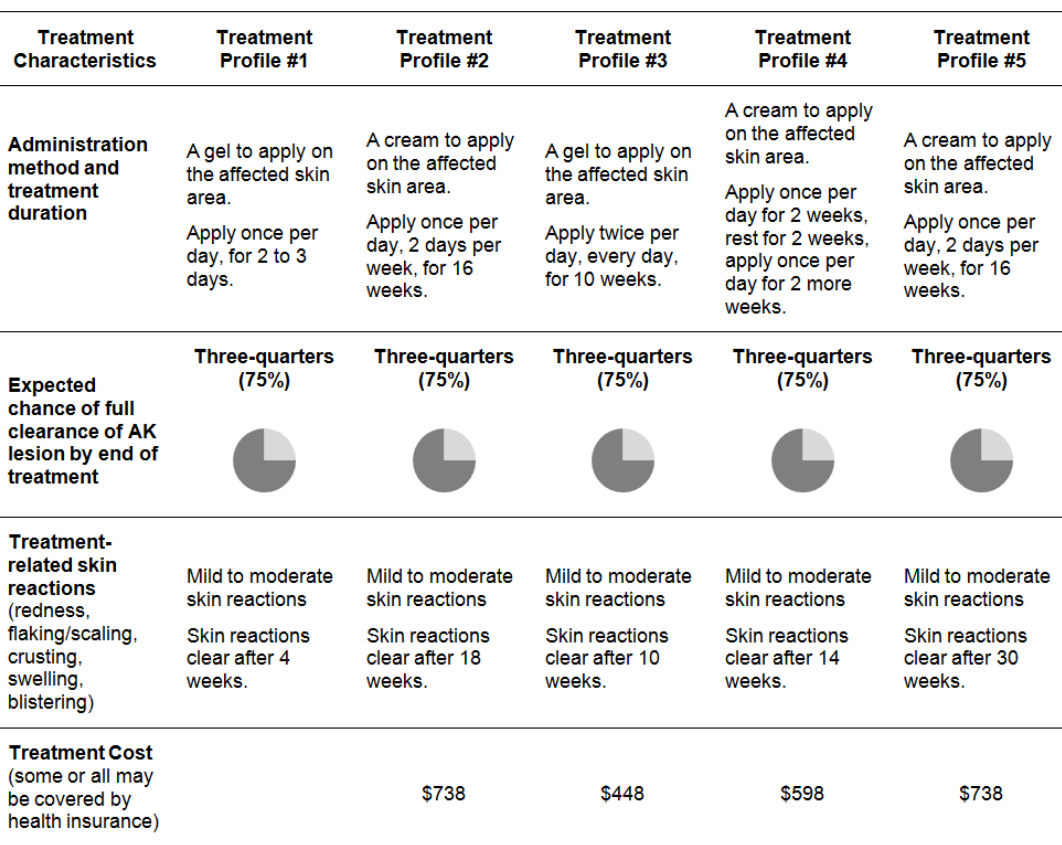
Figure 1. Treatment